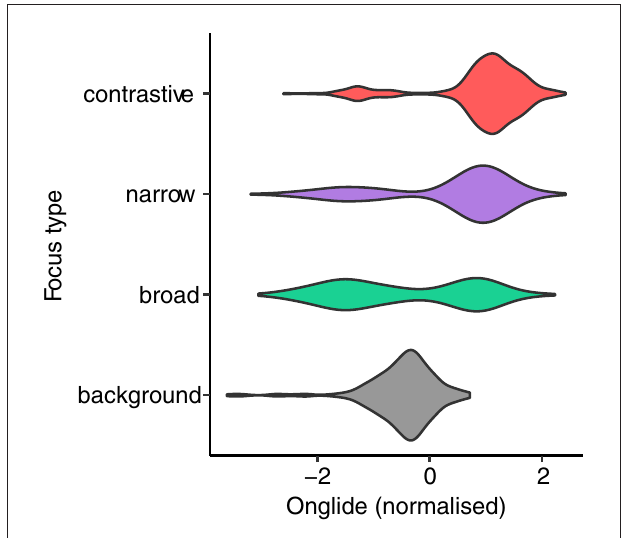
FIGURE 3 | Distribution of normalized onglide values.